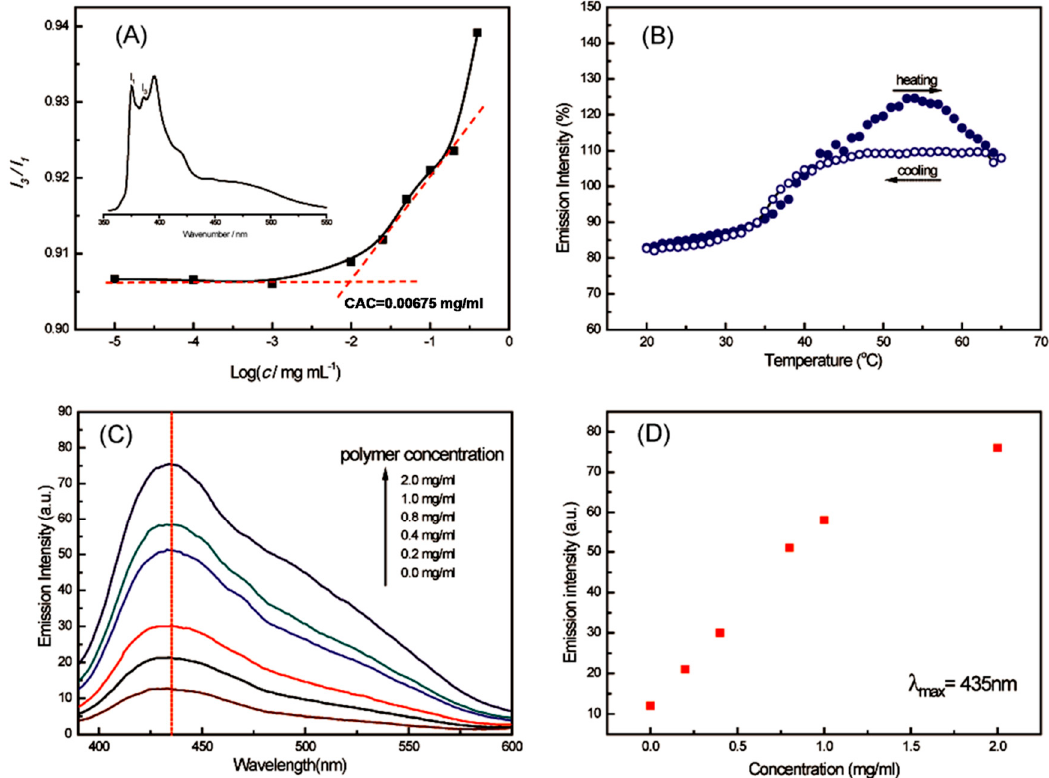
Figure 5. ( A ) Relationship between the fluorescence intensity ratio ( I 3 / I 1 ) and LCHBPNIPAM concentration in aqueous solution (Inset: fluorescence emission spectrum of pyrene); ( B ) maximum values of ANS aqueous solution (0.05 mM, λ max = 435 nm) in the presence of LCHBPNIPAM solution (0.2 mg/mL) with the gradual elevation and reduction of temperature; ( C ) fluorescence spectra of ANS in the presence of LCHBPNIPAM with various concentrations at 20 °C; and ( D ) maximum values of ANS emission intensity at various LCHBPNIPAM concentrations ((ANS) = 0.05 mM).